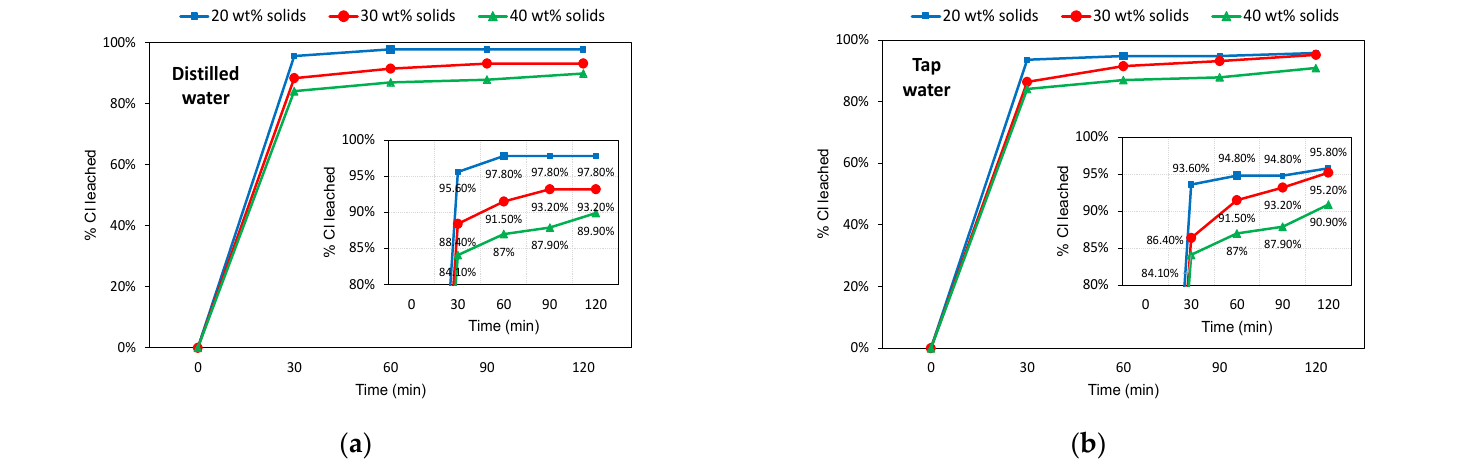
Figure 6. Leaching efficiencies (% Cl removed) over time for the − 0.5 mm slag samples. ( a ) Distilled water system; ( b ) Tap water system.